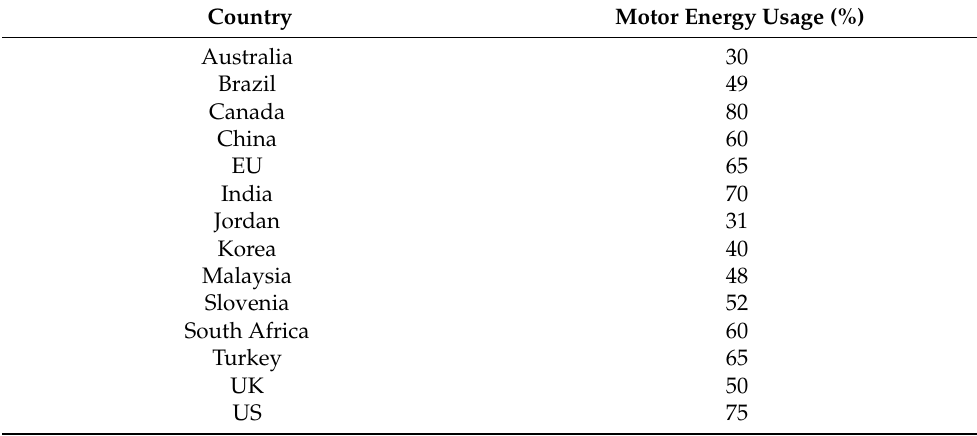
Table 1. Motor energy usage around the world